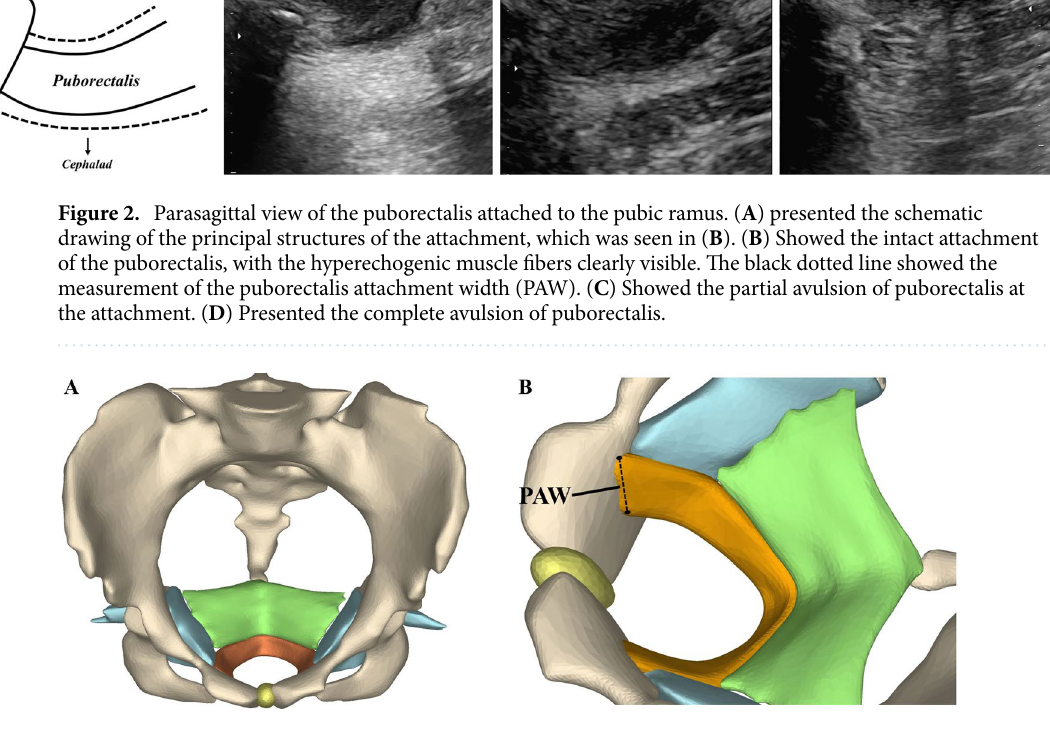
Figure 3. ( A ) The three-dimensional magnetic-resonance based model of pelvic floor. ( B ) The measurement of the puborectalis attachment width (PAW). Showing structures in color. The puborectalis in orange, the iliococcygeus in green, the internal obturator muscle in blue, the pelvic bone in light yellow and the pubic symphysis in dark